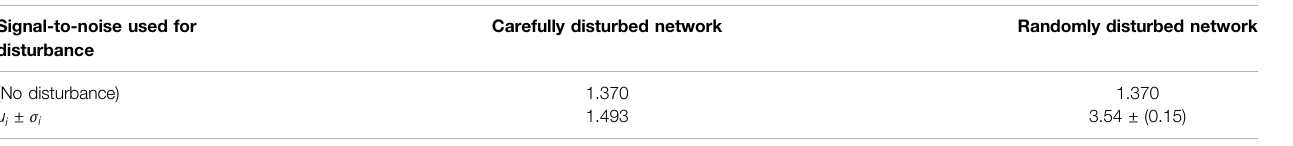
TABLE 3 | Inference results of disturbed networks for Model-III on analog hardware. Signal-to-noise used for